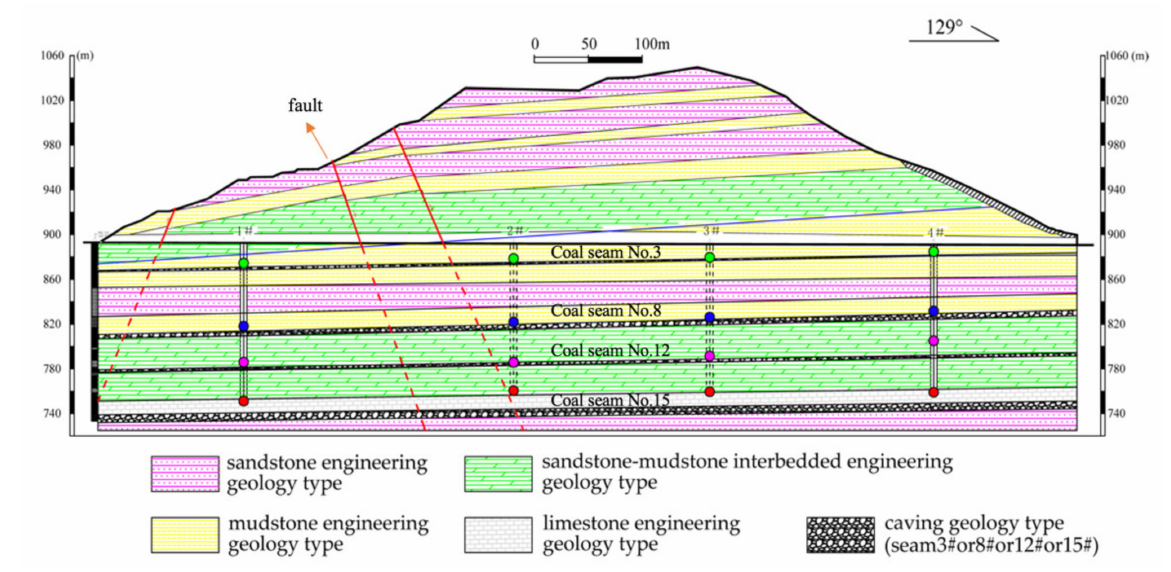
Figure 2. Engineering geological types of the Tianzimiao tunnel. In the engineering geological mapping of the mountain, the development of mountain cracks was specially investigated and measured, which was mainly carried out on the top of the mountain, and the distribution and strike rose diagram of cracks were plotted (Figure 3).